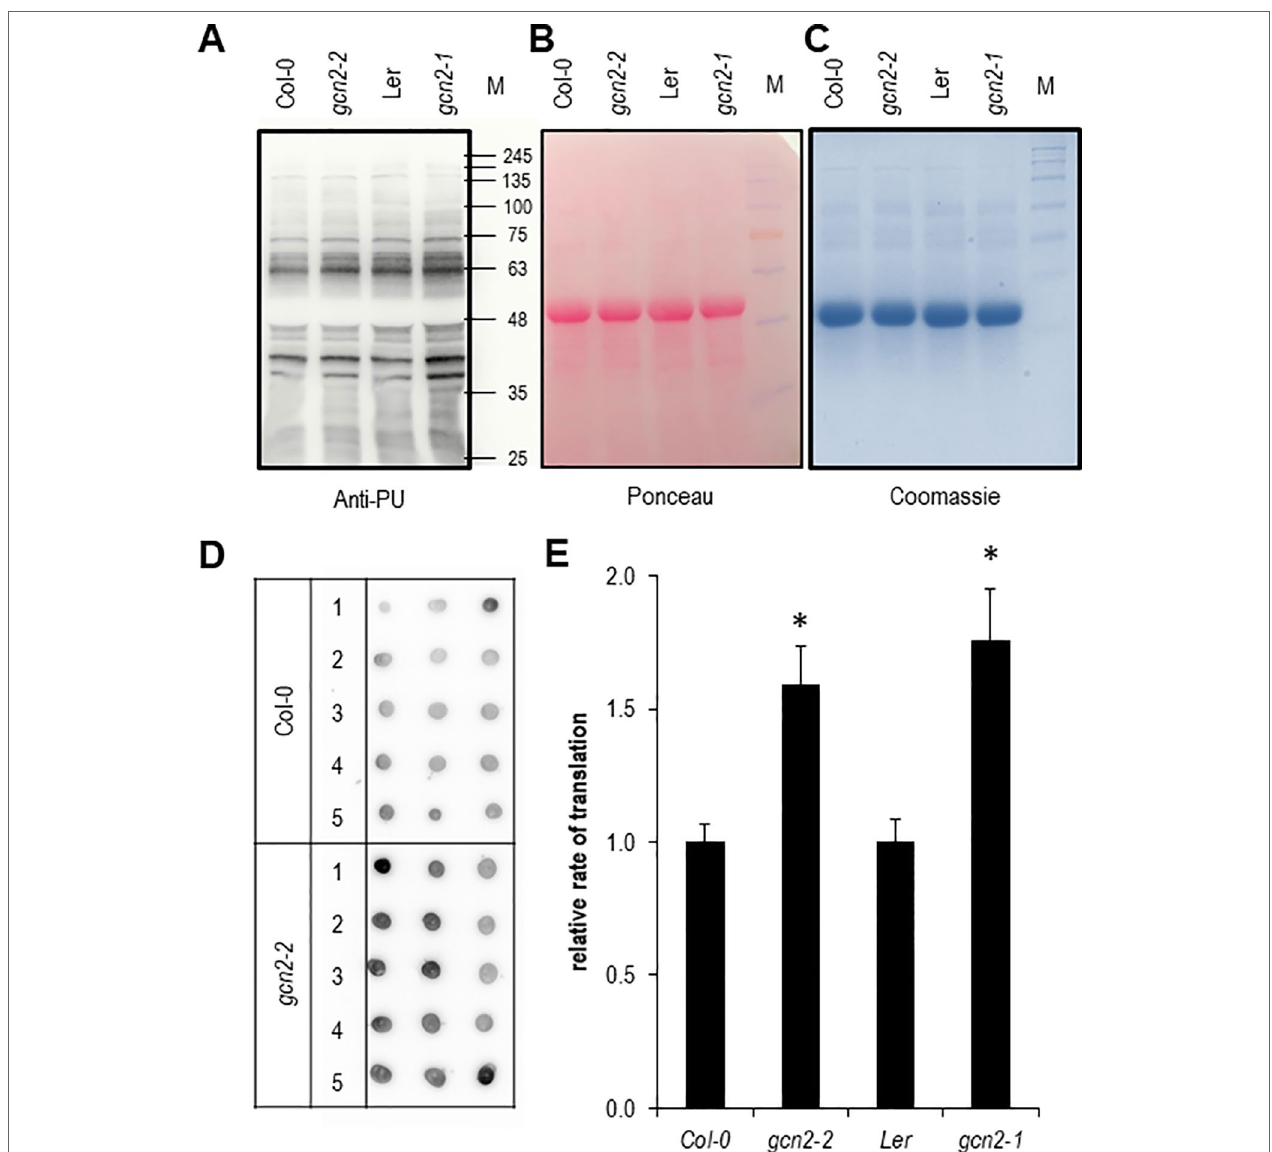
FIGURe 5 | Quantification of the rate of protein biosynthesis using puromycin (PU) (A) Anti-PU Western blot with wildtype and gcn2 mutants. To confirm equal loading of the 10% sodium dodecyl sulfate polyacrylamide gel electrophoresis, the membrane was stained with (B) Ponceau S and (C) Coomassie. (D) Example of a dot blot analysis with total protein extracts of PU treated seedlings where PU incorporation was detected with anti-PU antibodies. (e) Quantification of the dot blot analyses. Bars represent means and SE of at least 15 dots per experiment. Data of Col-0 and gcn2-2 are means of three independent experiments, data from Ler and gcn2-1 from a single experiment. Stars indicate significant differences (p < 0.05) between wildtype and mutants calculated with Student’s t- test. M designates the protein size marker line.